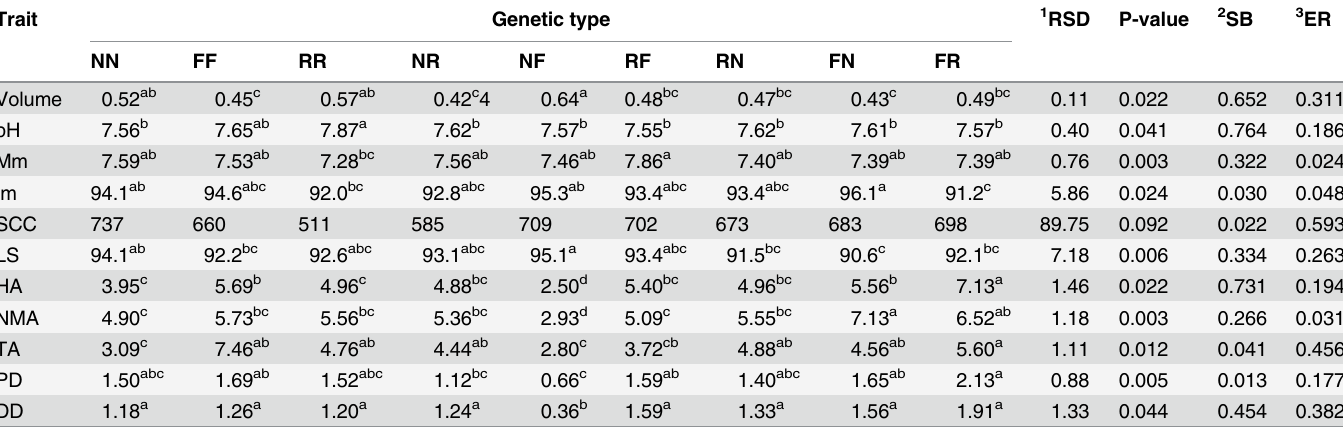
Table 1. Semen quality traits and sperm cell morphological abnormalities (%) for the first generation of purebred and crossbred male rabbits. Trait